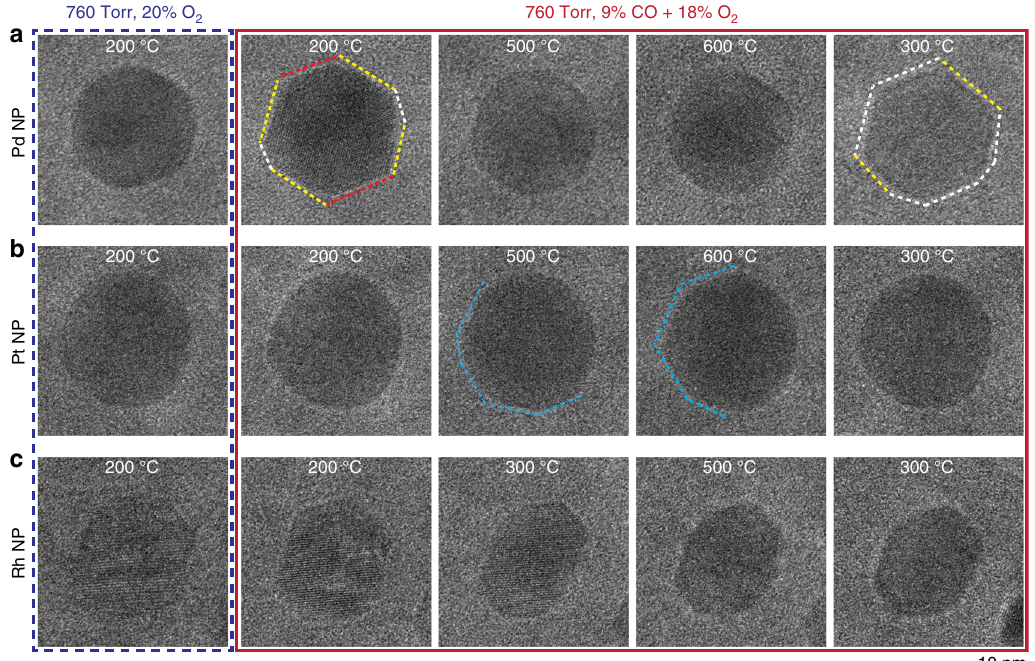
Fig. 4 A comparison of Pd, Pt, and Rh NPs during CO oxidation. TEM image sequences of ~10-nm a Pd, b Pt, and c Rh NPs under similar reactions ¼ 0 : conditions P CO P O 2